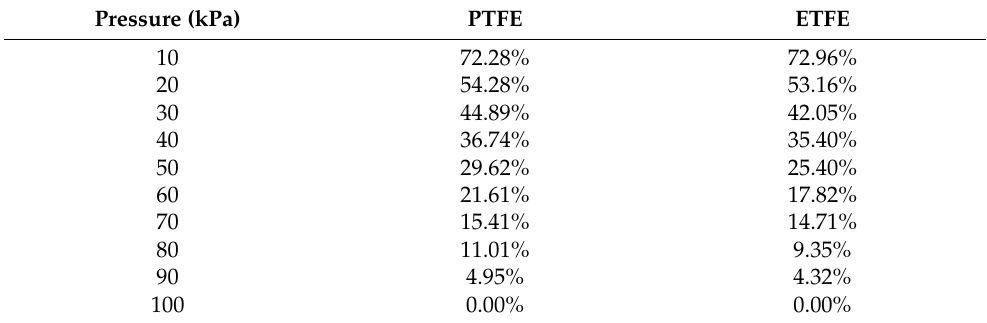
Table 6. CEV values reduction (%) as a function of the pressure with respect to the value at 100 kPa. Pressure (kPa)